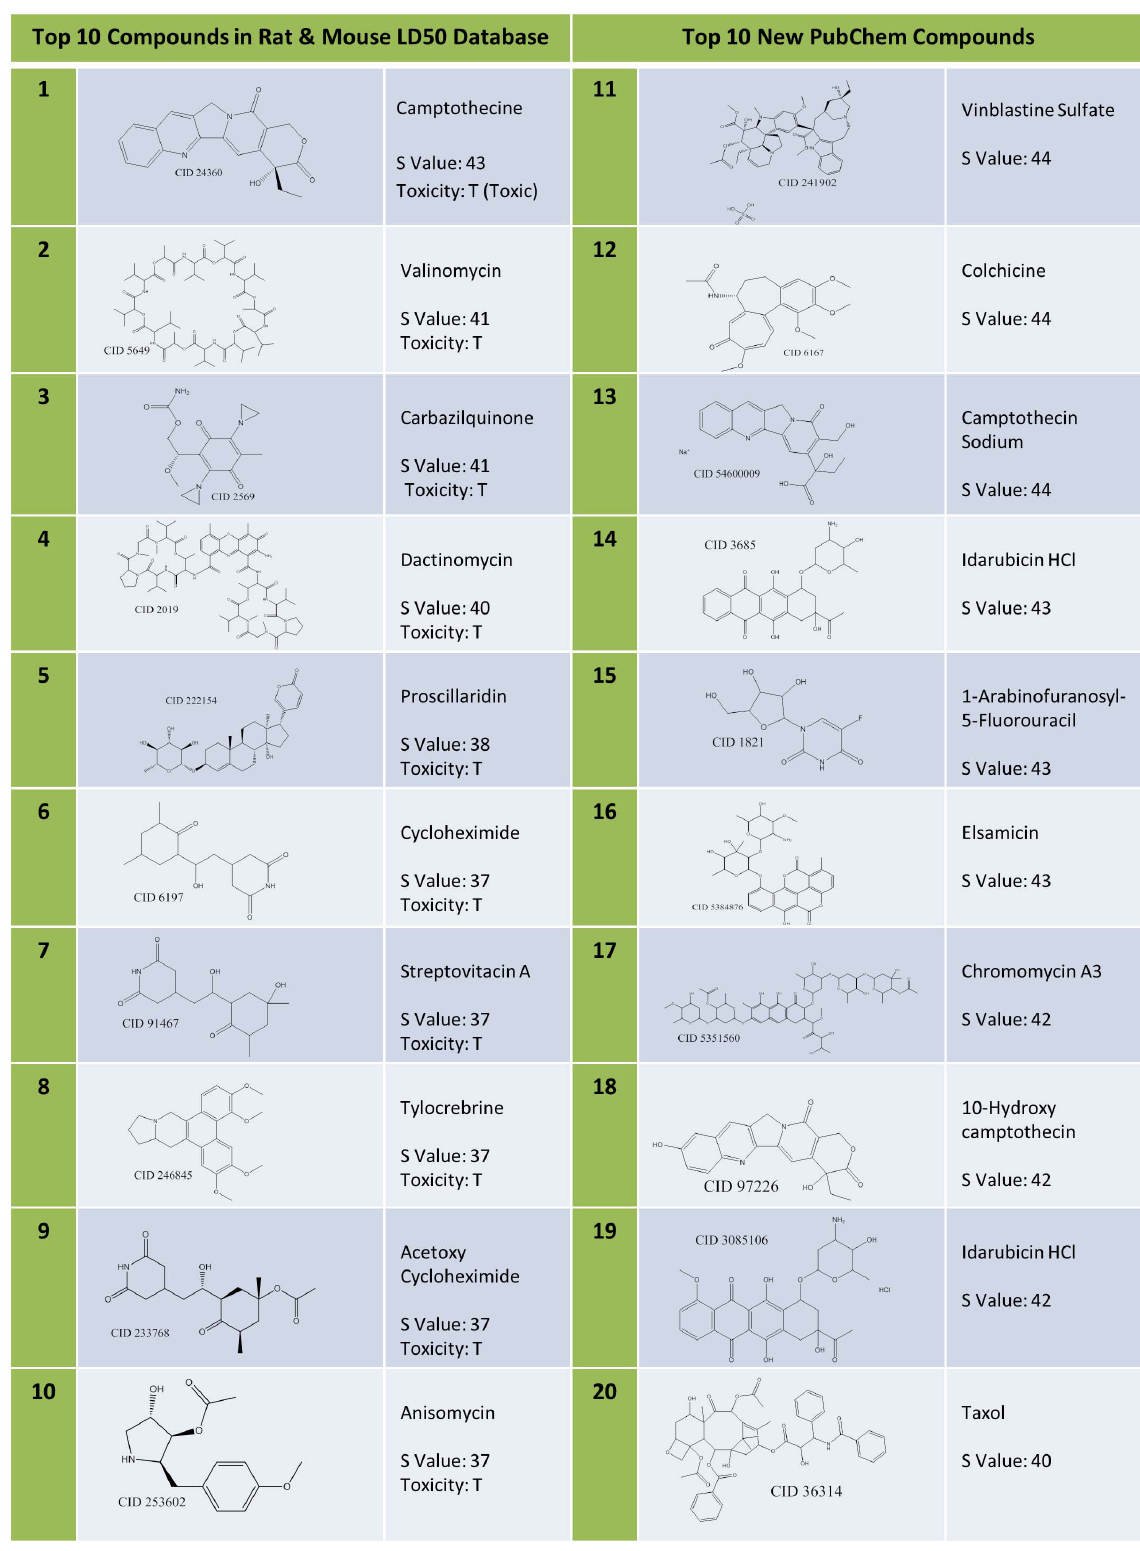
Figure 6. The list of the top ten compounds with the highest S values from our acute toxicity database (1–10) and from data mining of new PubChem compounds (11–20). The toxicity related excerpts and sources for the new PubChem compounds were listed in Table S3.